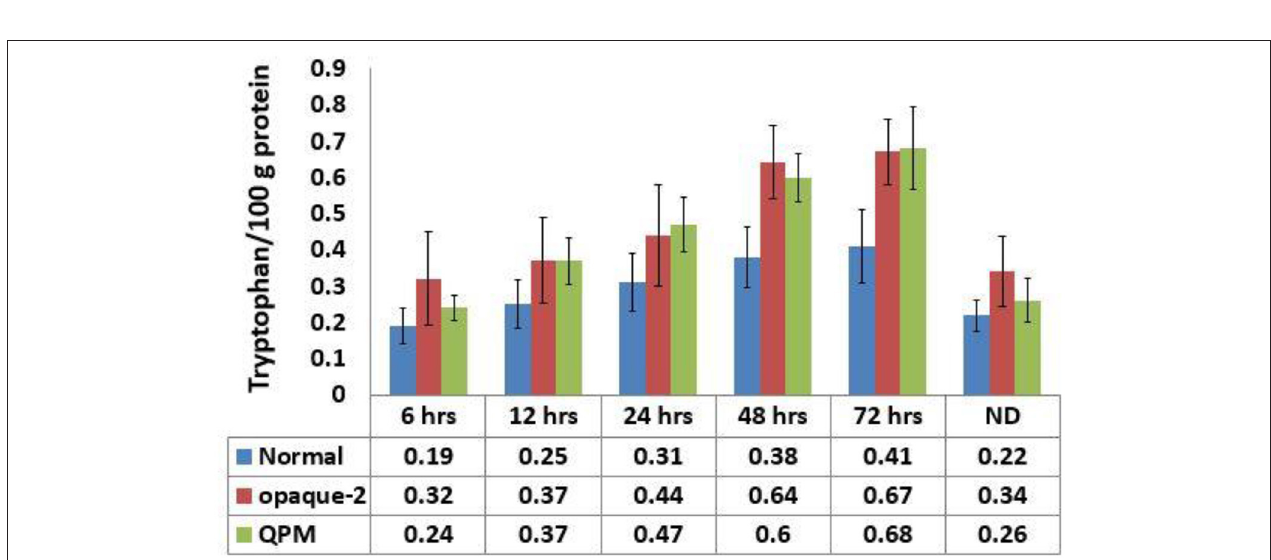
FIGURE 2 | Heat map depicting rate of extracted oil (%) at different time intervals.